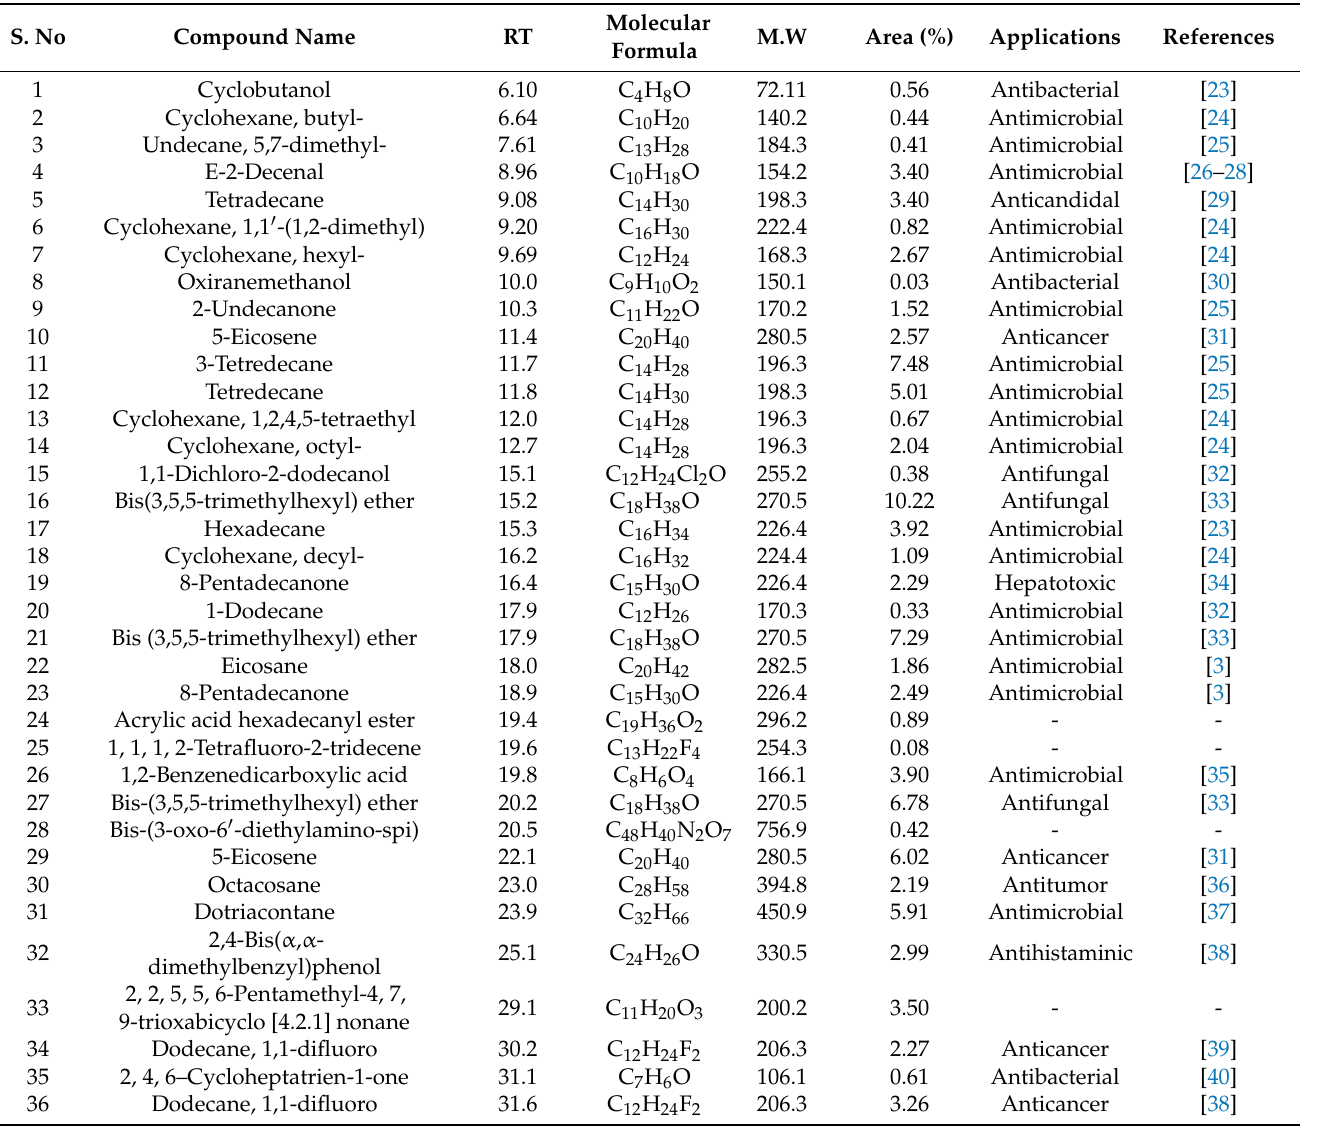
Table 6. Compound analysis by GC–MS for EtOAc extract of Streptomyces sp. strain